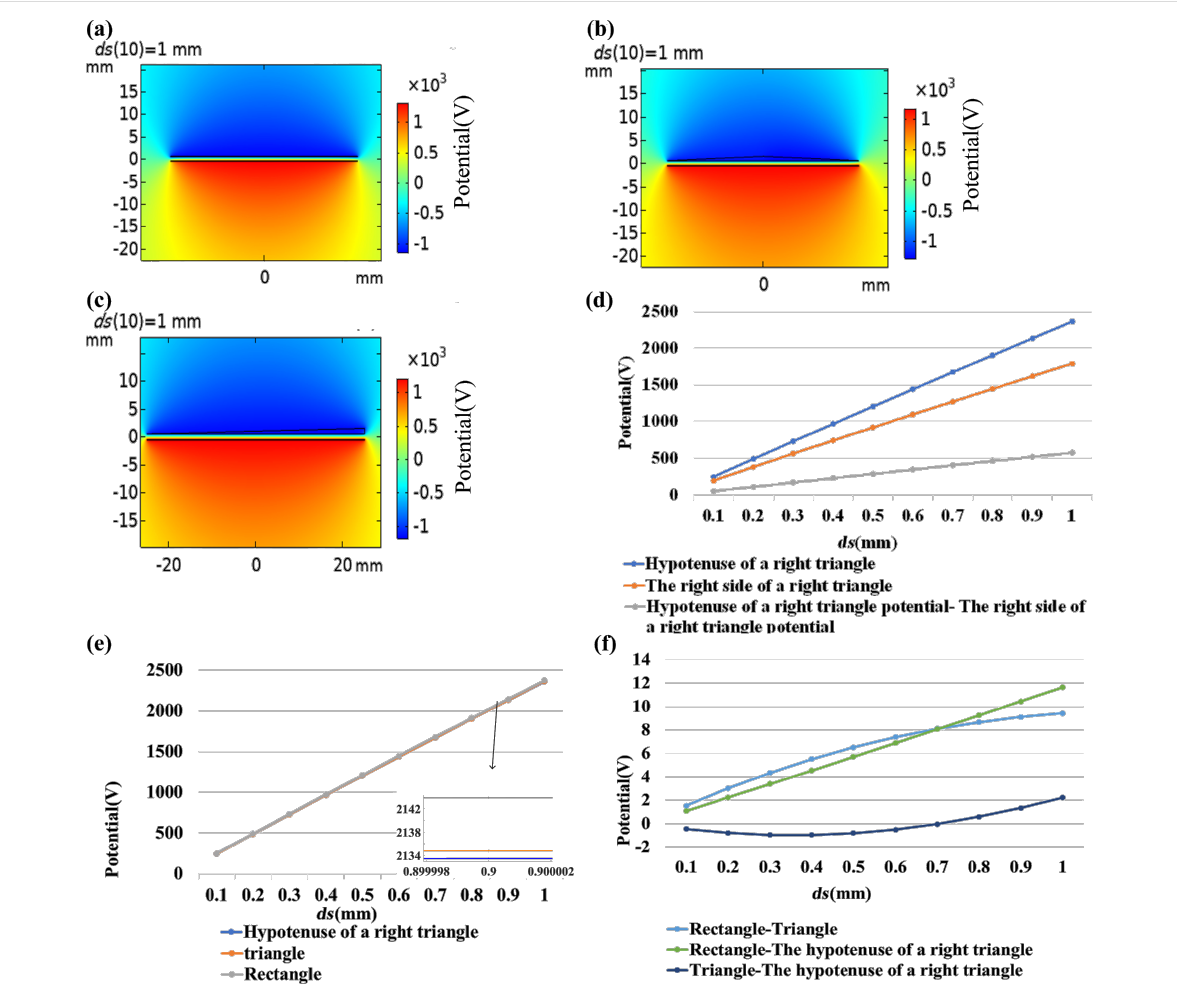
Figure 5: Comparison of shapes. (a) Potential distribution diagram of a rectangular TENG. (b) Potential distribution diagram of an isosceles triangle TENG. (c) Potential distribution diagram of a right-angled triangle TENG. (d) Outer boundary potential and potential difference of a right-angled trian- gle TENG. (e) Potential of the three shapes of TENG. (f) Potential difference of the three shapes of TENG.